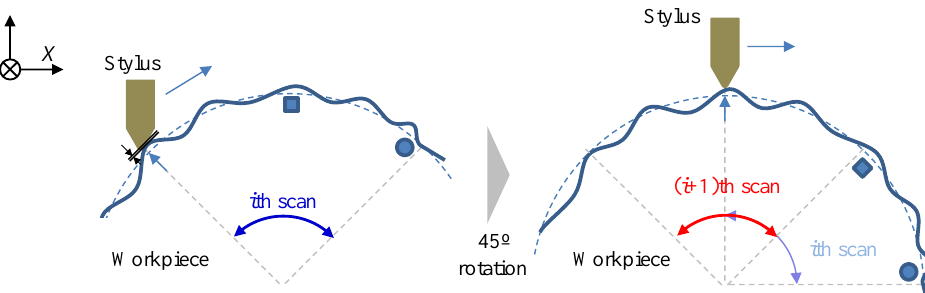
Figure 4. The influence of the pressure angle of a probe of the linear-scan stylus profiler.